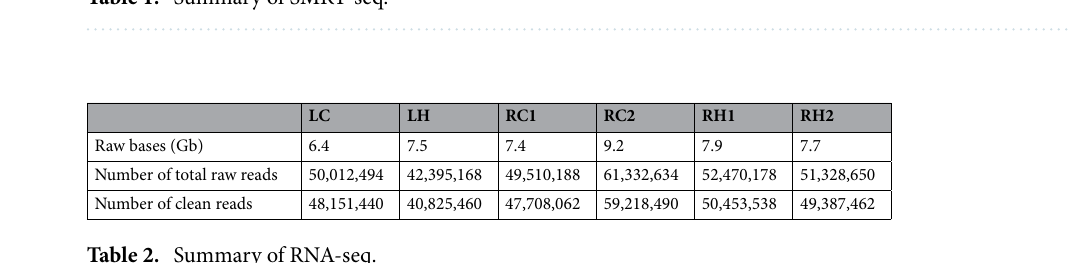
Table 1. Summary of SMRT-seq.